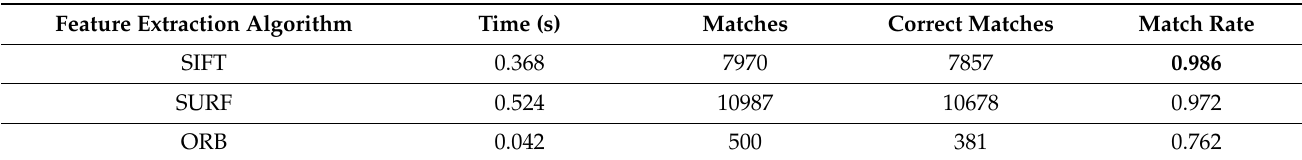
Table 4. Results of comparing the image with the image changed in brightness. The best result is marked in bold.